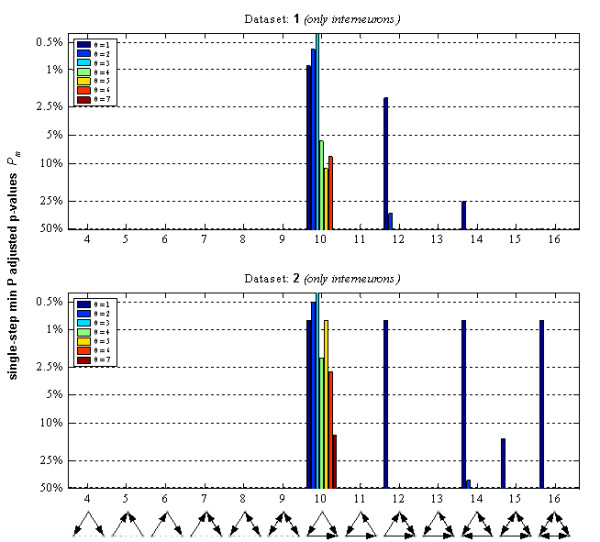
Significance measure Pm of triplet over-representation among interneurons shows that pattern #10 is significantly over-represented. Multiple hypothesis testing corrected p-values for the triplet over-representation in datasets 1 and 2 (n = 1000). The figure shows that motif #10 is significantly over-represented within interneurons.